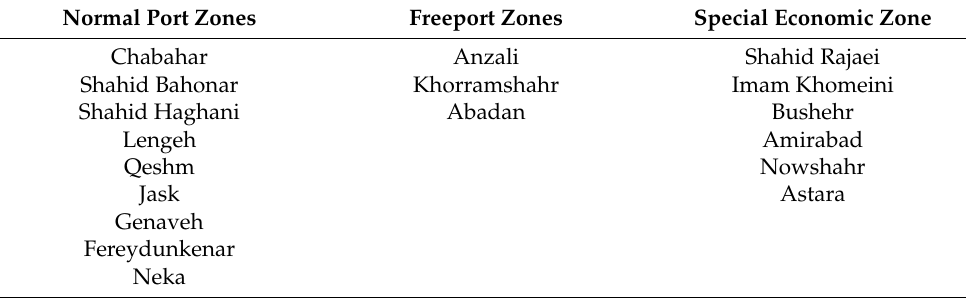
Table 1. Iranian commercial